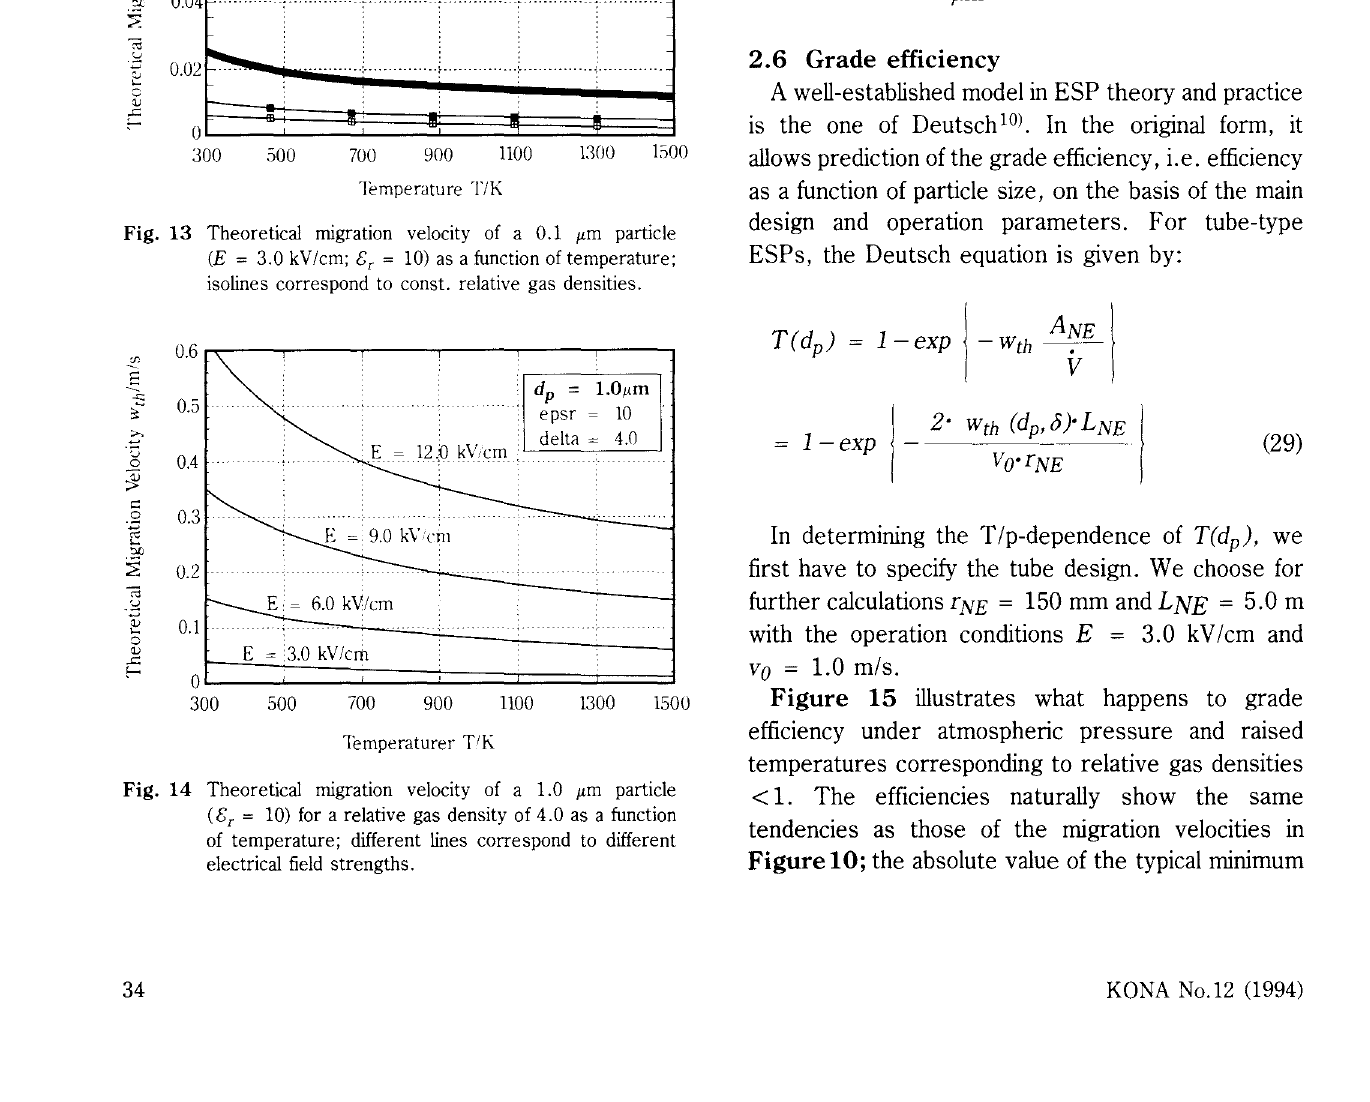
Fig. 14 Theoretical migration velocity of a 1.0 I'm particle (6r = 10) for a relative gas density of 4.0 as a function of temperature; different lines correspond to different electrical field